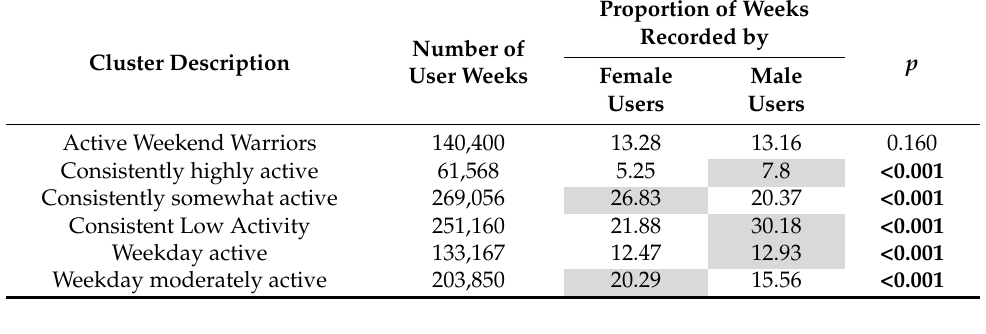
Table 4. Gender and activity behaviour characteristics of k-means weekly physical activity behaviour clusters. Bold font indicates a statistically significant associating, significantly higher proportions are shaded grey.